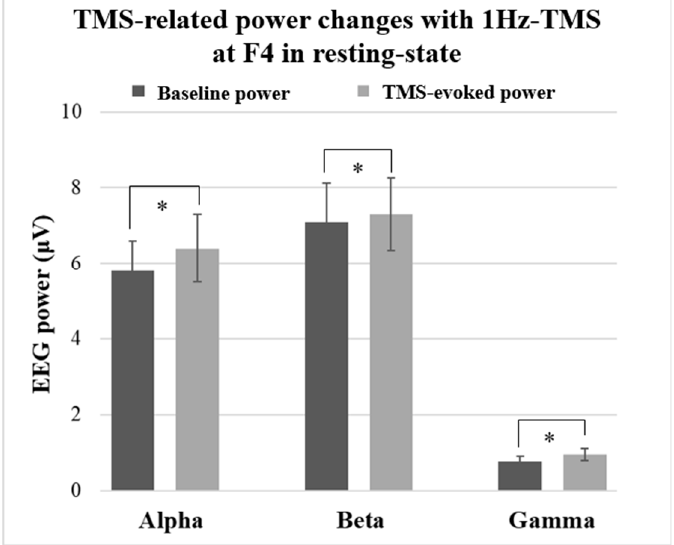
Figure 2. TMS-related power changes at F3 in the resting-state. The spectral power changes at the F4 electrode site after 100 pulses of 1Hz-TMS to the right dorsolateral prefrontal cortex (DLPFC) showed 10.2% increase in the alpha band (F 1,20 = 132.4, p < 0.0001), 2.2% increase in the beta band (F 1,20 = 1824.7, p < 0.0001), and 51% increase in the gamma band (F 1,20 = 1028.5, p < 0.0001). *: significant findings ( p < 0.0083).